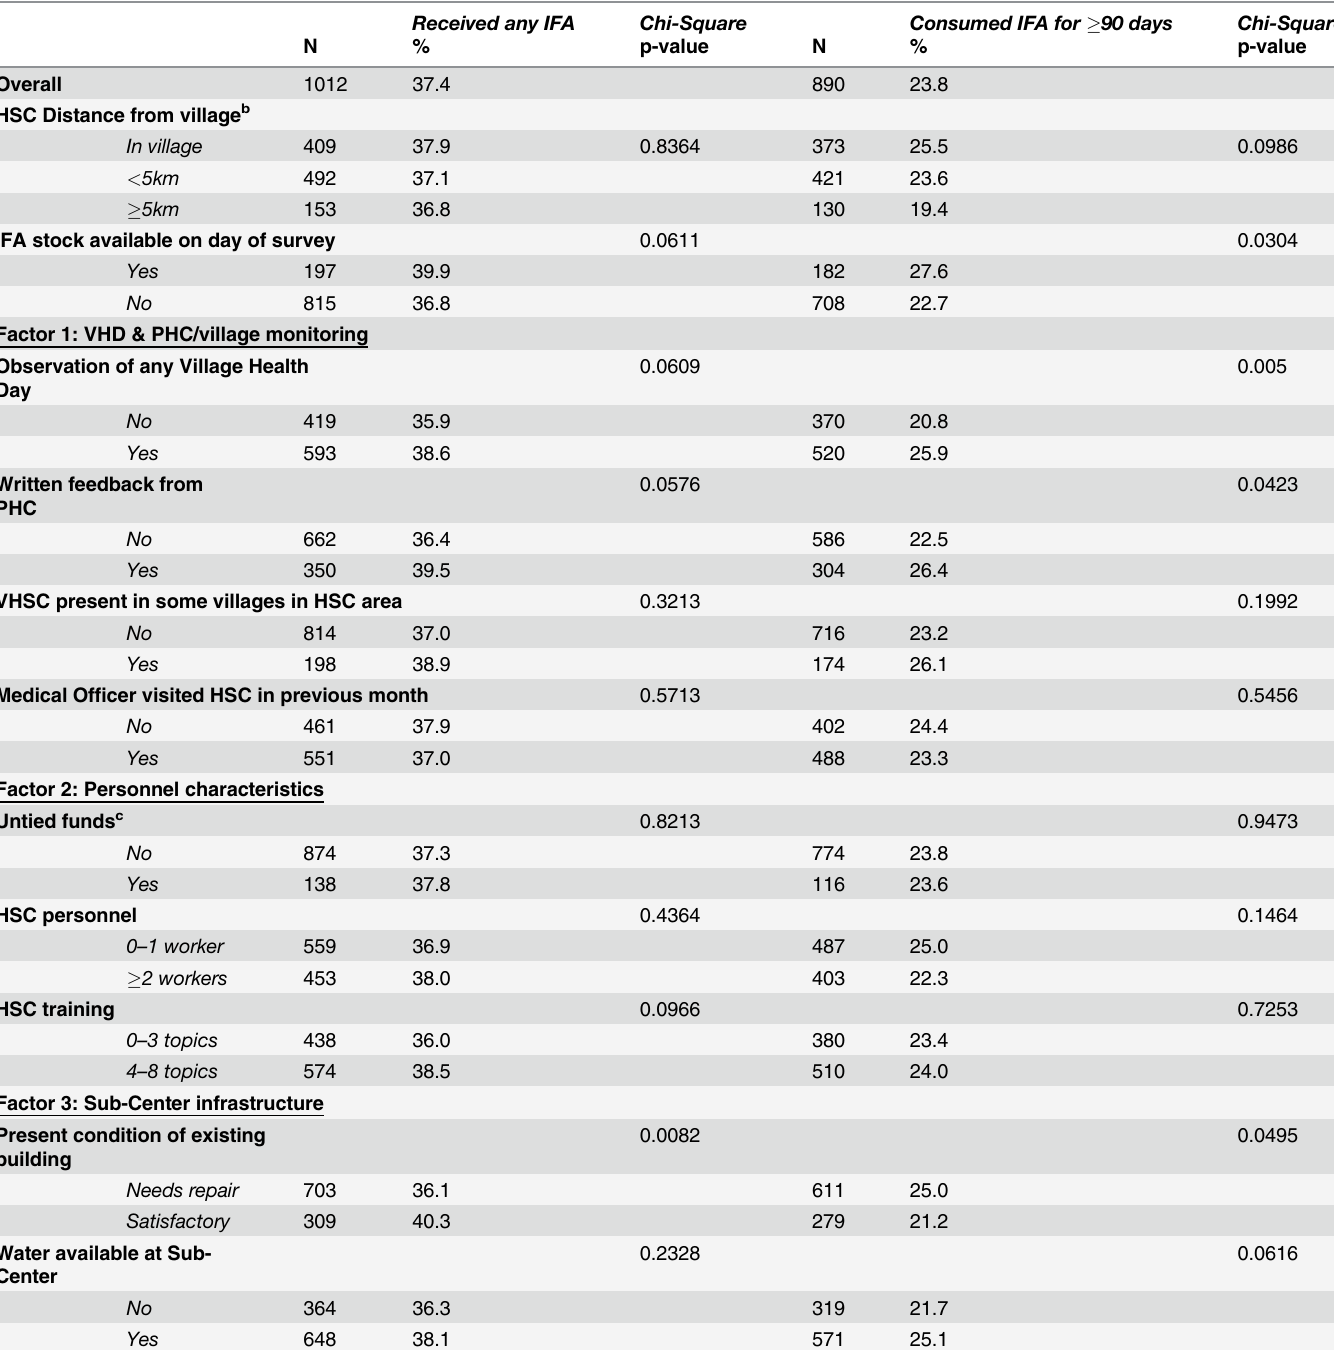
Table 5. Facility-level factors of study population by prevalence of iron and folic acid receipt and consumption a